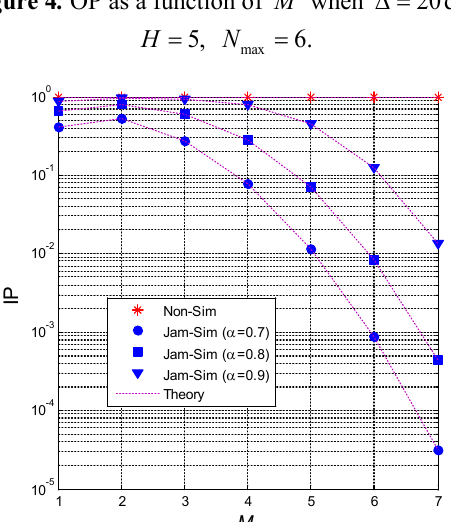
Figure 5 . IP as a function of M when 20dB, D=